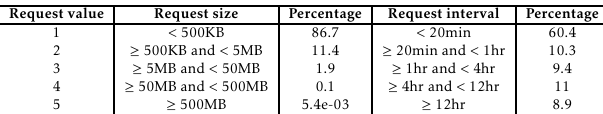
Table 3. Mapping of request sizes to relative request